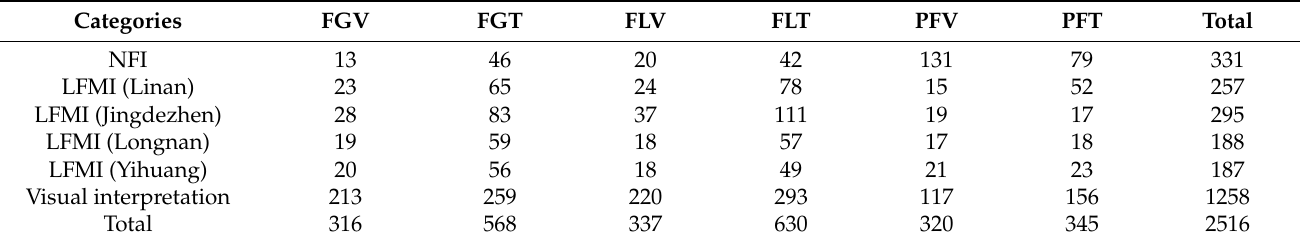
Table 1. The sources, categories and numbers of sampling plot data. NFI: national forest resource inventory; LFMI: local forest management inventory.